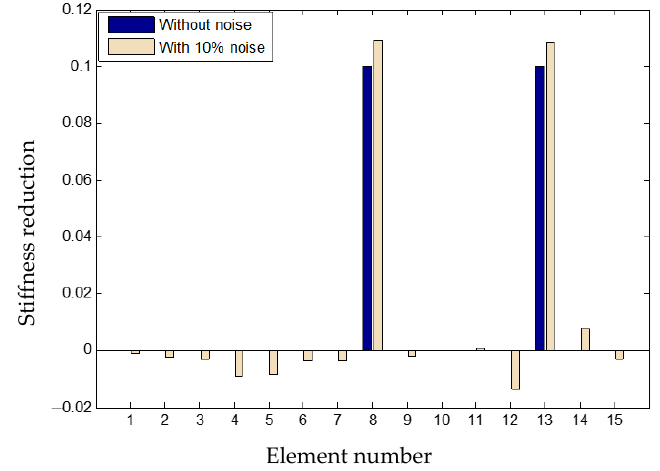
Figure 7. Damage identification result (scenarios 1 and 2).